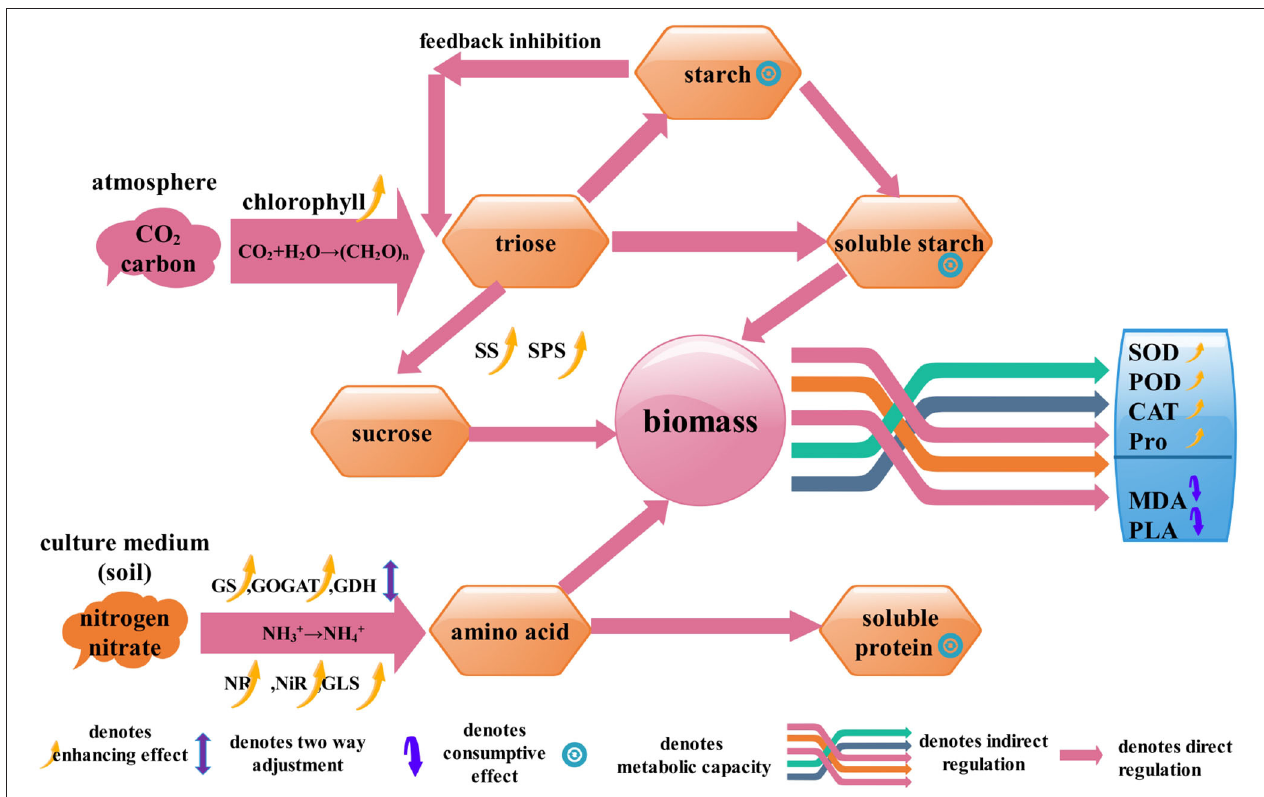
FIGURE 1 | The path structure of biomass accumulation of S.miltiorrhiza . It shows the process of C/N metabolism and the role of the physiological/biochemical indicators in biomass